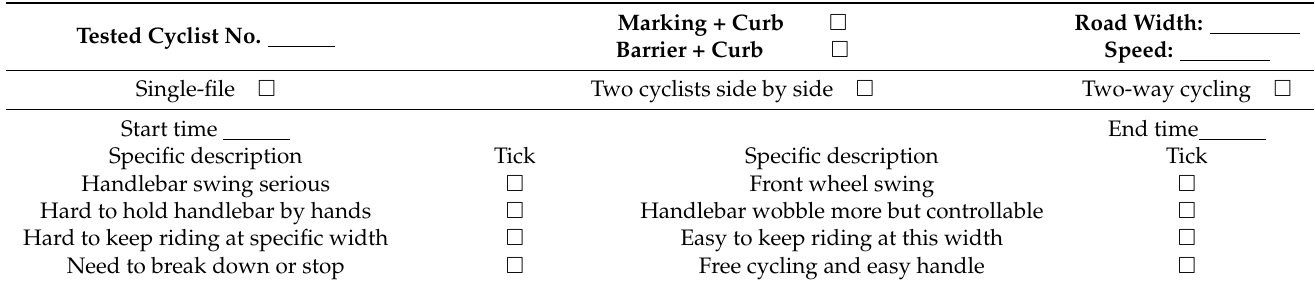
Table 5. Subjective scale for qualitative evaluation the cycling